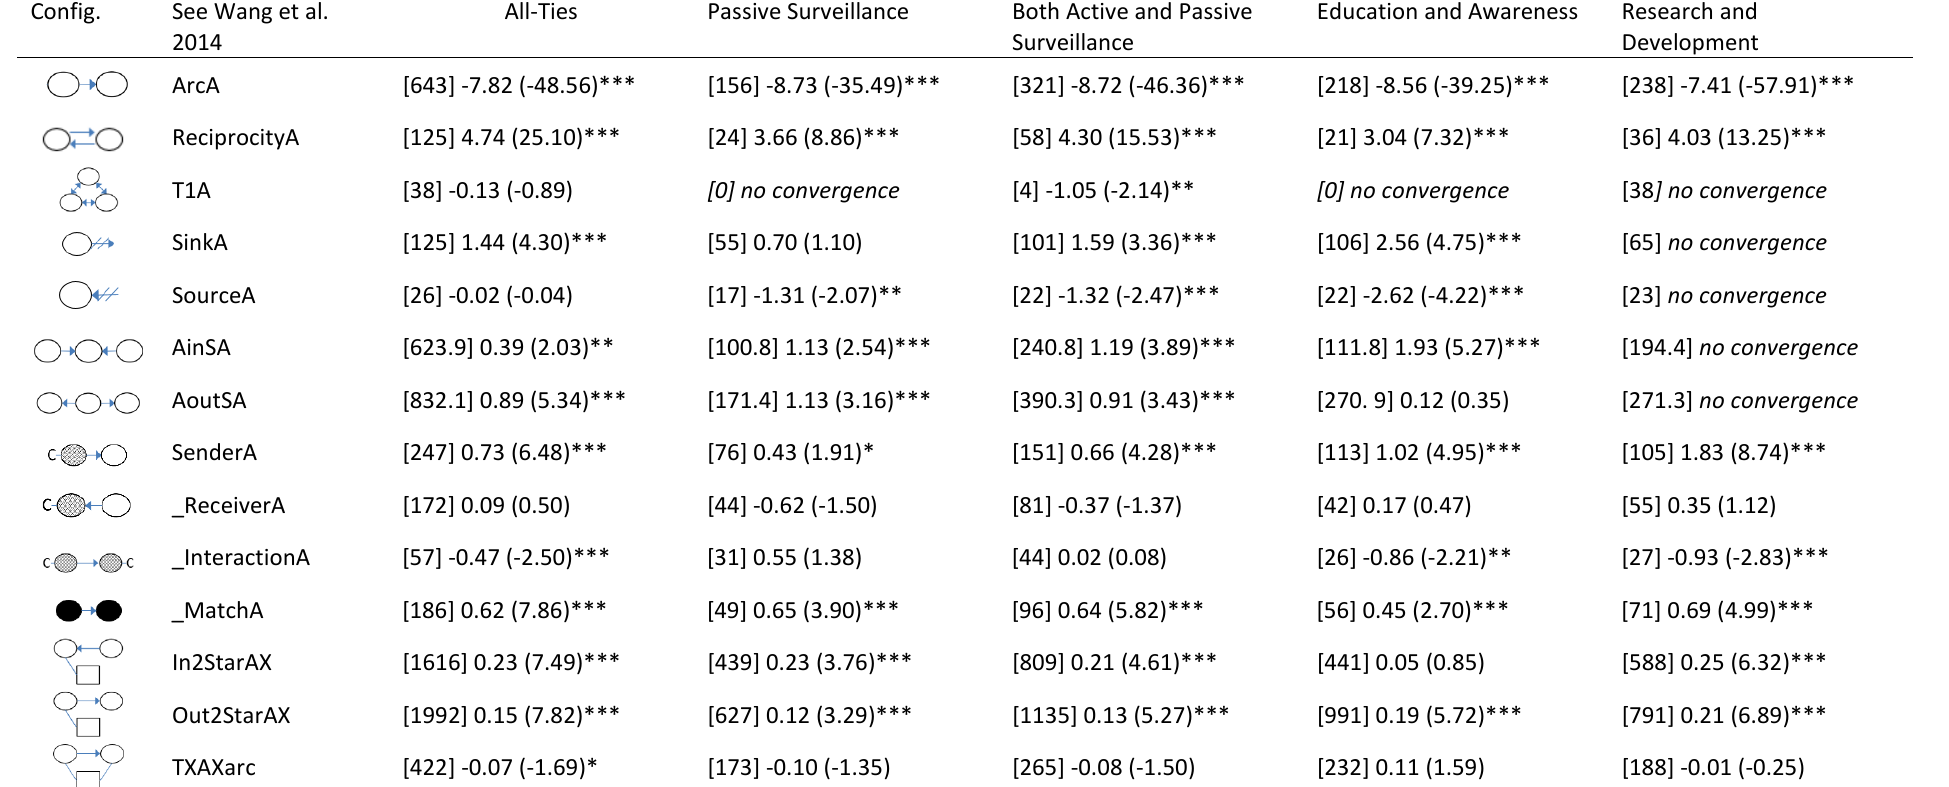
Table A1.1: Exponential Random Graph Models; fixed meso-level (actor-forums) network. Count, model parameter, t-score for parameter, with */**/*** signifying 90/95/99% significance.